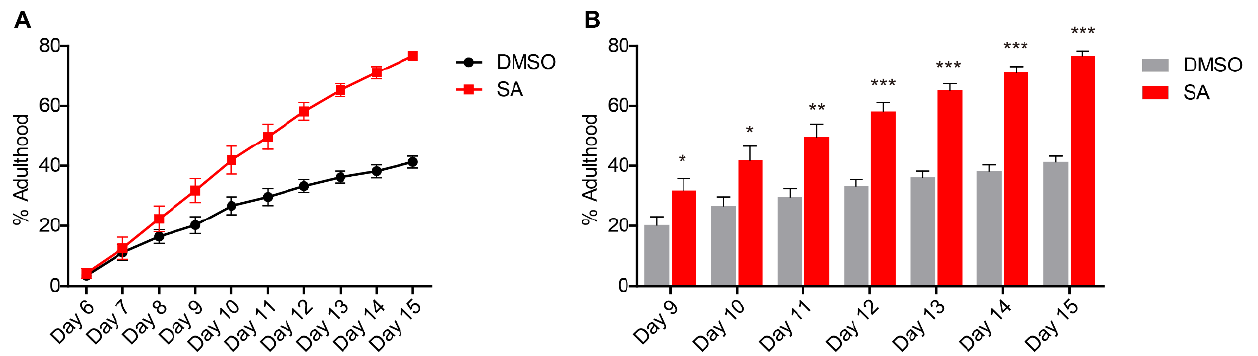
Figure 1. Stearic acid promoted L. marina growth on sea-salt-CeMM diet. ( A , B ) Daily adult rates of L. marina with dietary supplementation of SA (stearic acid) or DMSO (solvent control). ( A ) and ( B ) are different representations of the same set of data. DMSO, 6 trials, n = 52 worms on average in each trial; SA, 6 trials, n = 52 worms on average in each trial. All data shown are mean ± SEM (standard error of mean). * p < 0.05, ** p < 0.01, *** p < 0.001; two-sided t -test.